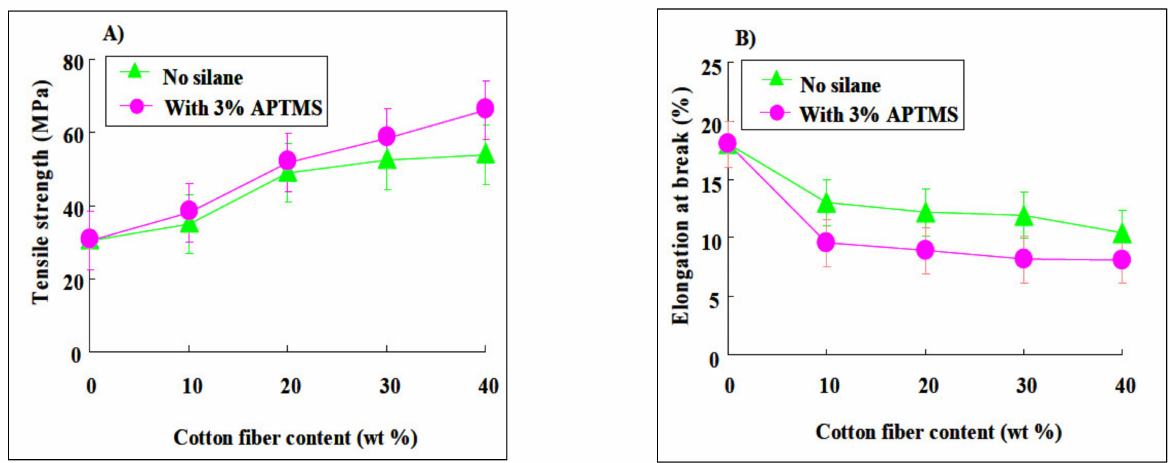
Figure 12. ( A )Tensile strength and ( B ) elongation at break of PBS/cotton fiber composite [8]. Adapted with permission from Calabia et al.